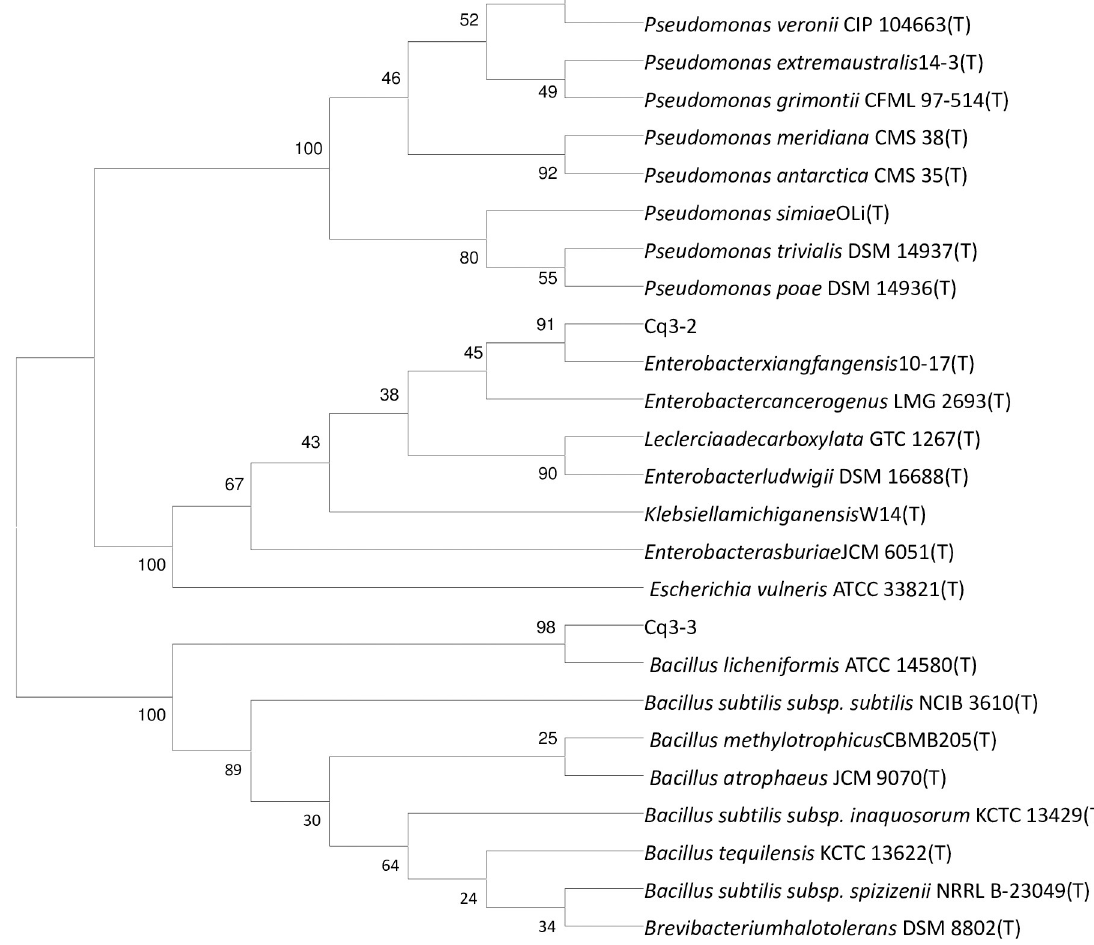
Fig 7. Evolutionary tree of the relationships among reference strains and tested strains based on 16S rDNA.